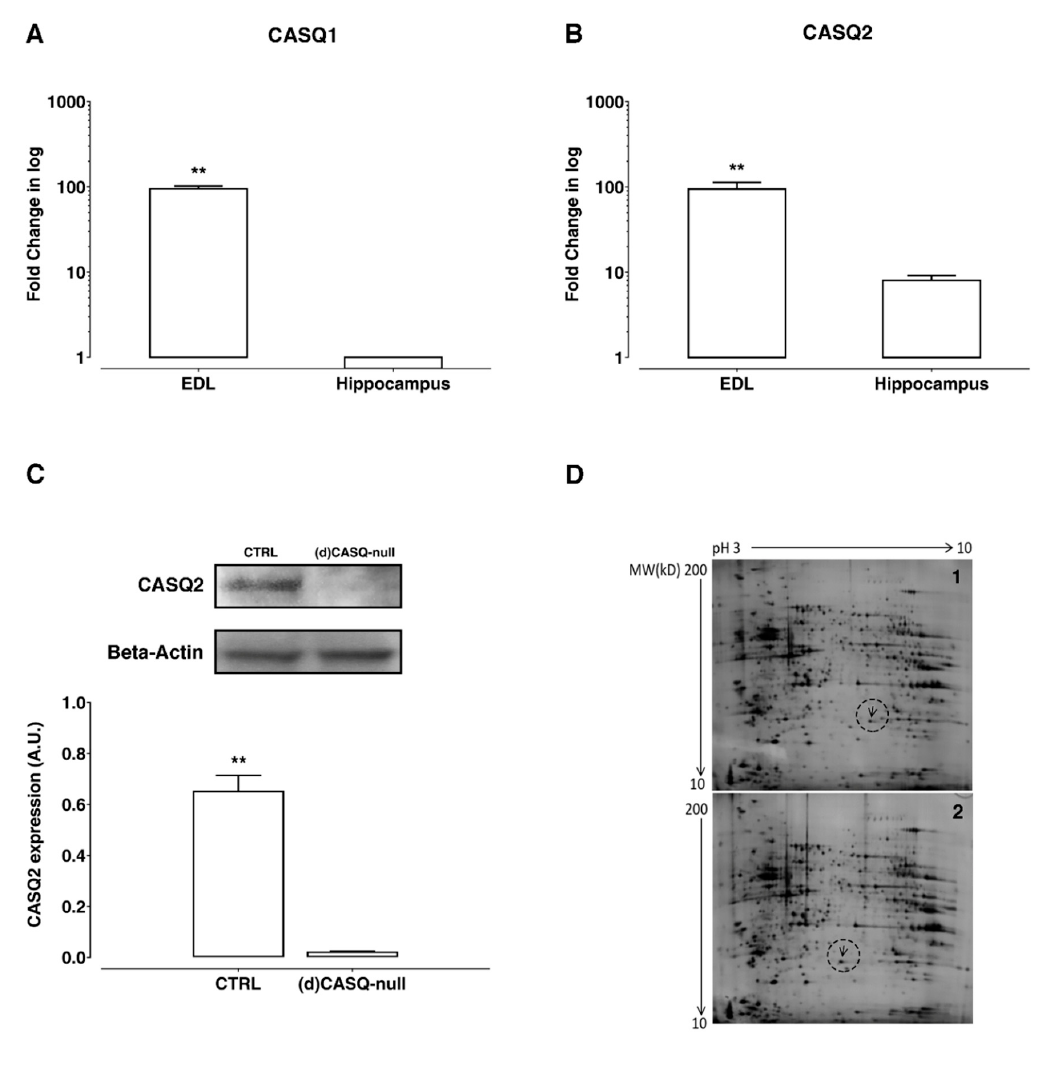
Figure 1. Biochemical evaluations in hippocampi. ( A , B ) Calsequestrin (CASQ) 1 and CASQ2 mRNA levels in the hippocampus of control (CTRL) mice vs. extensor digitorum longus (EDL) muscle of the same group ( n = 3). Student’s t-test: CASQ1 t(22) = 20.95, ** p < 0.01; CASQ2 t(22) = 7.01 , ** p < 0.01. ( C ) CASQ2 protein expression in the hippocampus of CTRL vs. (d)CASQ-null mice ( n = 3 for each group). Bars represent the signal intensity of protein bands in arbitrary units (A.U.) after normalization with the signal intensity of Beta-Actin used as a loading control for each sample. Student’s t-test: t(16) = 10.26, ** p < 0.01. ( D ) Two-dimensional gel electrophoresis (2DE) maps of hippocampus proteins from CTRL (1) and (d)CASQ-null mice (2) ( n = 3 for each group). Arrows point to differentially expressed proteins.